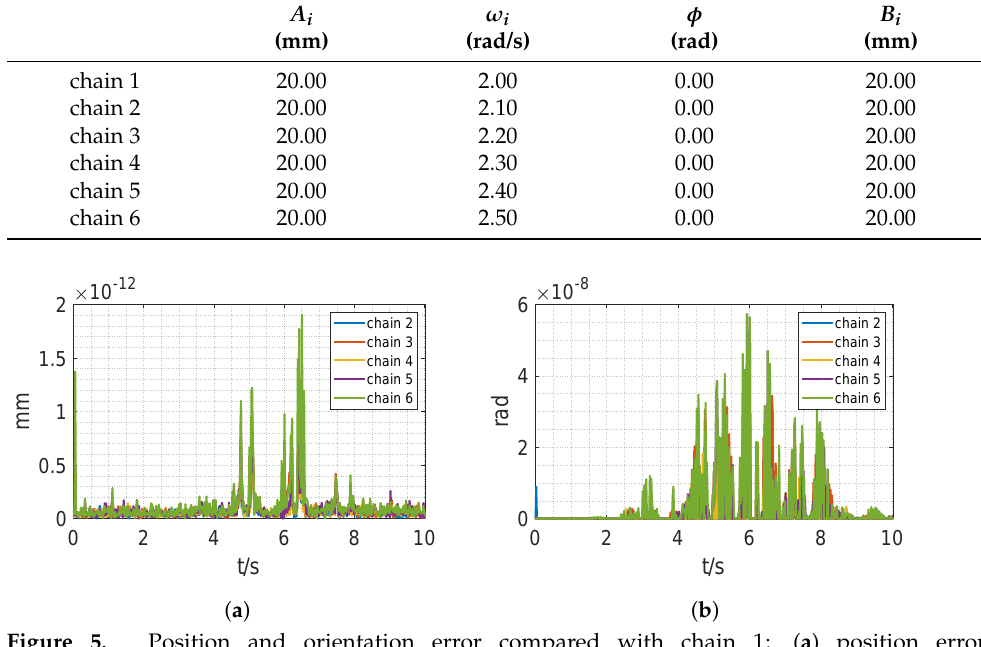
Figure 5. Position and orientation error compared with chain 1; ( a ) position error; ( b ) orientation error.